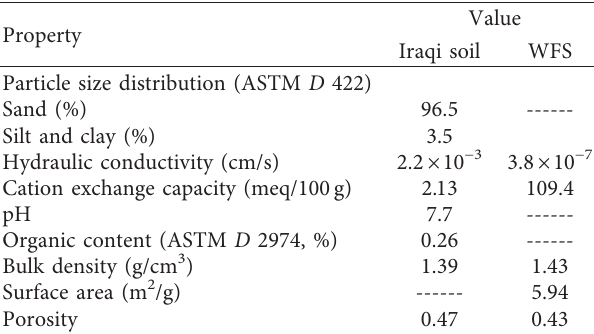
Table 1: Composition and properties of the Iraqi soil and WFS used in the present